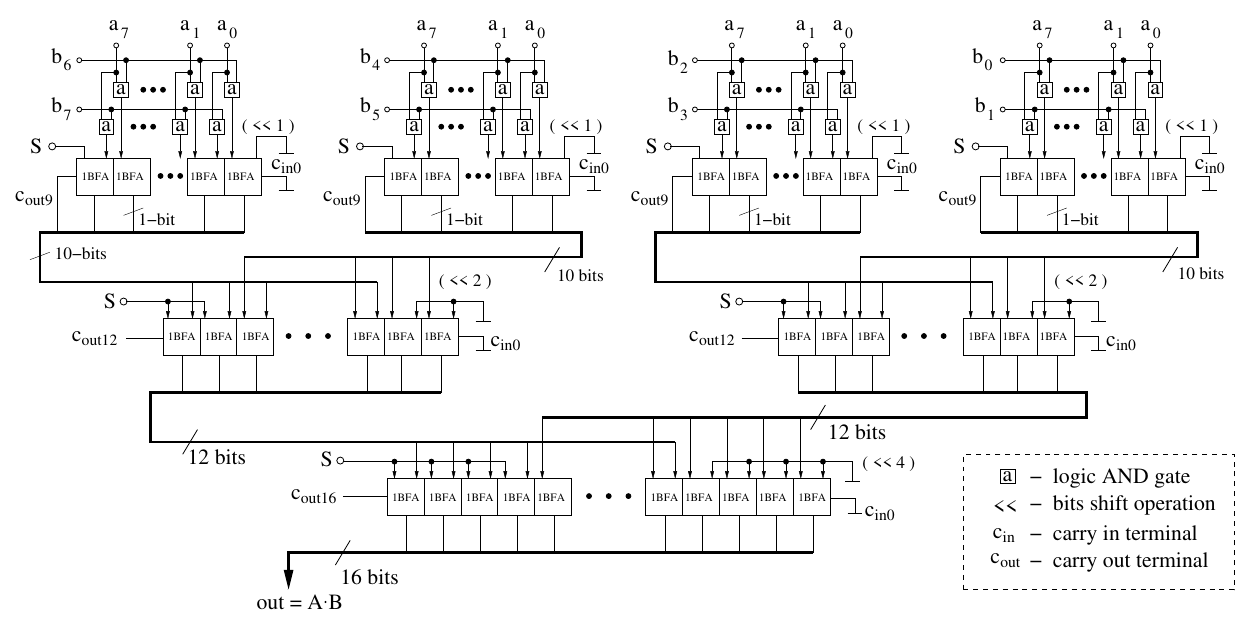
Figure 5. An asynchronous binary-tree multiplier for an example case of two 8-bit numbers. A multiplier of this type has been used in the proposed circuit shown in Figure